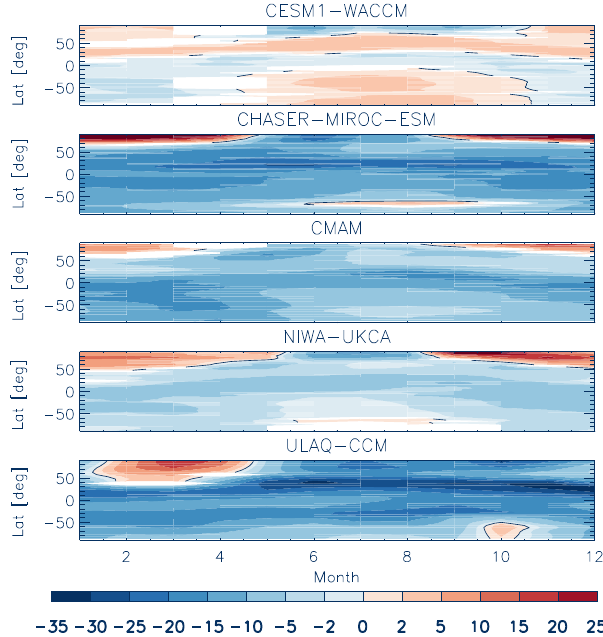
Figure 13. Ratio of zonal-mean surface ozone changes to changes in surface CO 2 eq . , times 10 6 , as derived from the REF-C2, SEN- C2-fGHG, SEN-C2-fCH4, and